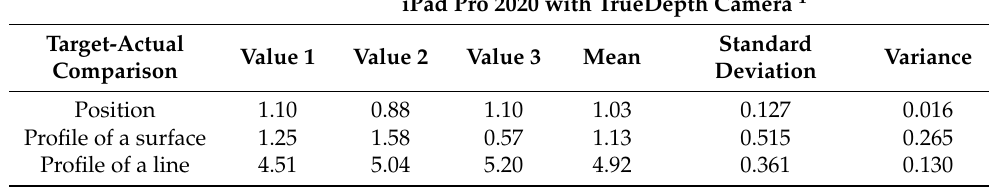
Table A6. Determined position and profile tolerance values of different Lego bricks scanned by the iPad Pro (2020) using